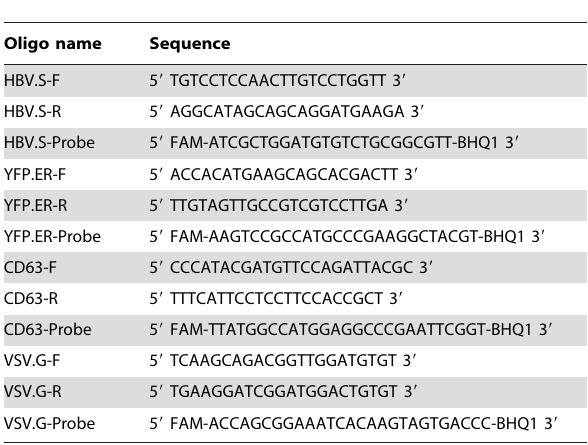
Table 1. List of primers and hydrolysis probes used in